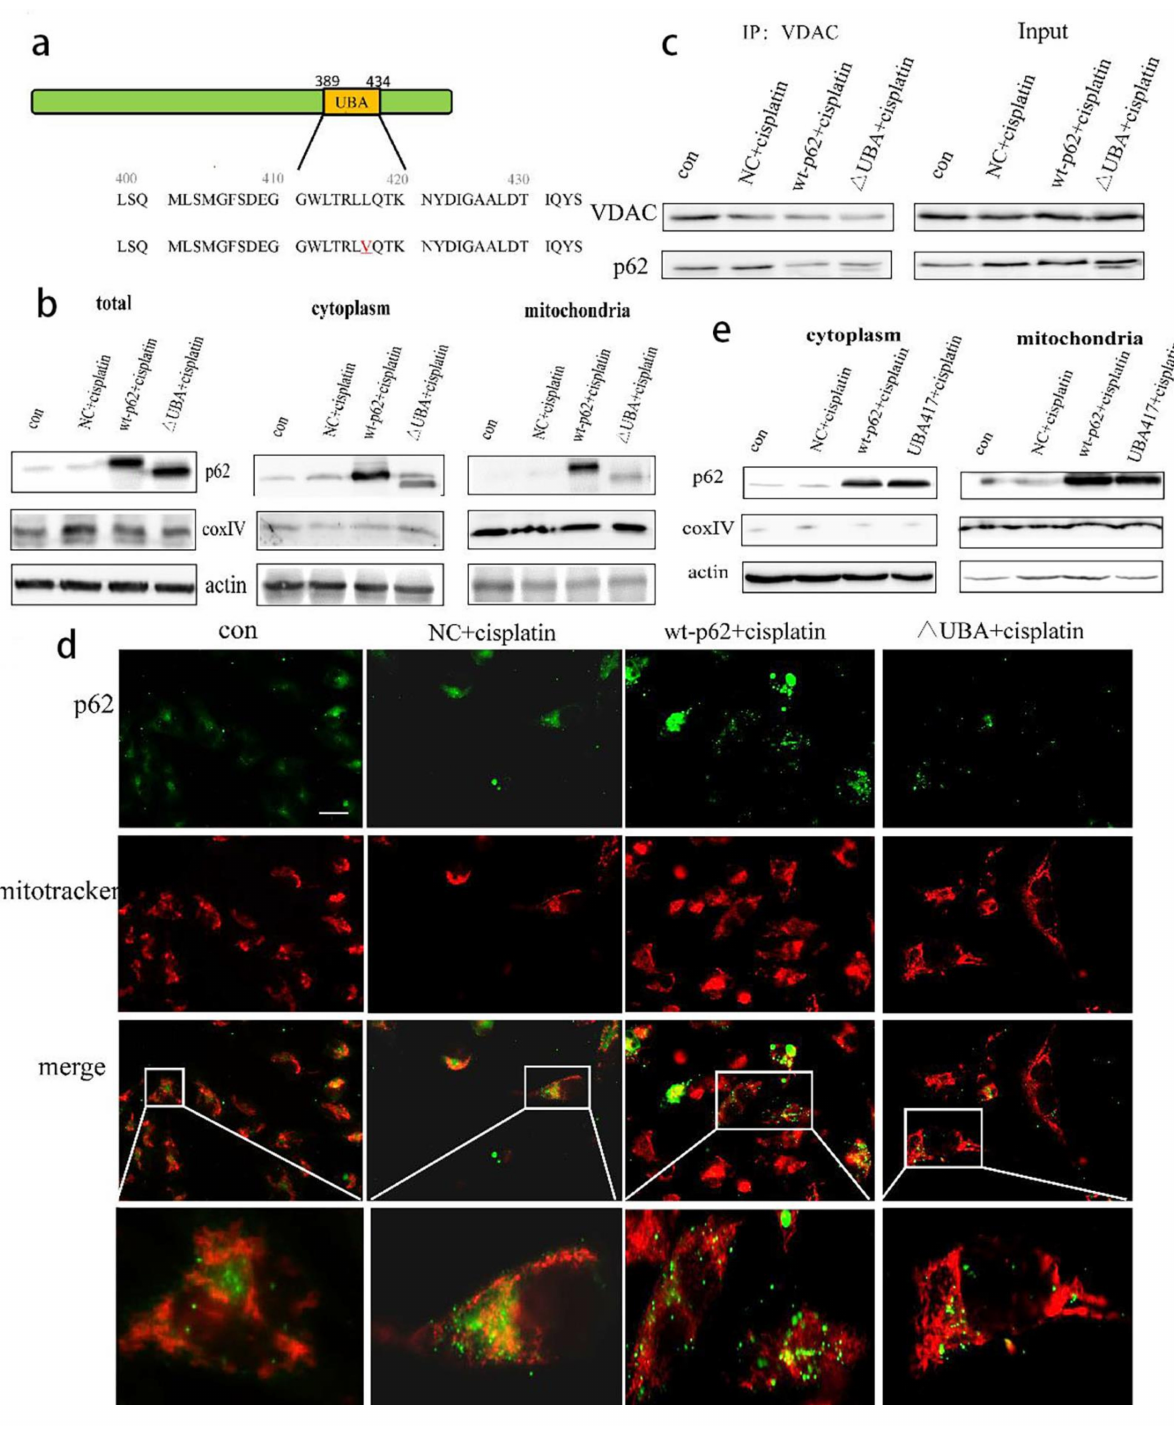
Figure 3. UBA domain determines the location of p62 on mitochondria. ( a ). Schematic representation of the p62 wild-type and mutant UBA domain constructs. ( b ). A2780 cells were transfected with wt-p62 or ∆ UBA-p62. Western blot analysis of p62, actin and coxIV in cell lysate and mitochondrial lysate in A2780 after treatment (cisplatin 5 µ g/mL, 6 h). ( c ) A2780 cells transfected with wt-p62 or ∆ UBA-p62 were treated with cisplatin 5 µ g/mL for 6 h. Immunoprecipitation was performed with the anti-VDAC1 antibody followed by Western blotting using anti-p62, anti-VDAC1. ( d ). A2780 cells were treated as in ( c ). Localisation of p62 and mitochondrial observed with microscopy. Scale bar, 10 µ m. ( e ). A2780 cells transfected with wt-p62 or UBA417-p62 were treated with cisplatin 5 µ g/mL for 6 h. Western blot analysis of p62, actin and coxIV in cell lysate and mitochondrial